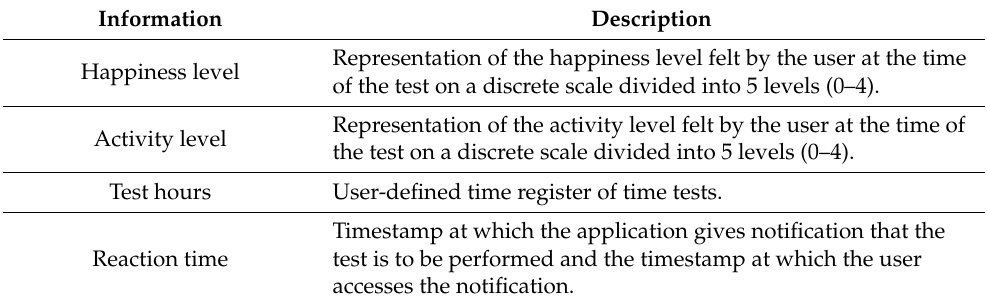
Table 1. Information collected by the Android. Information Representation of the happiness level felt by the user at the time Happiness level of the test on a discrete scale divided into 5 levels (0–4). Representation of the activity level felt by the user at the time of Activity level the test on a discrete scale divided into 5 levels (0–4). Test hours User-defined time register of time tests. Timestamp at which the application gives notification that Reaction time